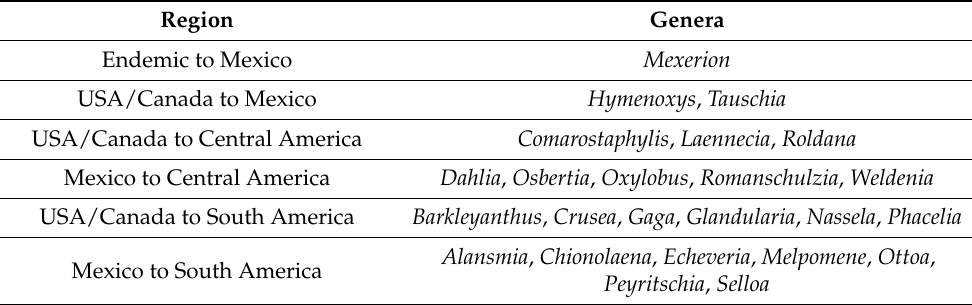
Table 3. Distribution of central Mexican alpine genera occurring only in the